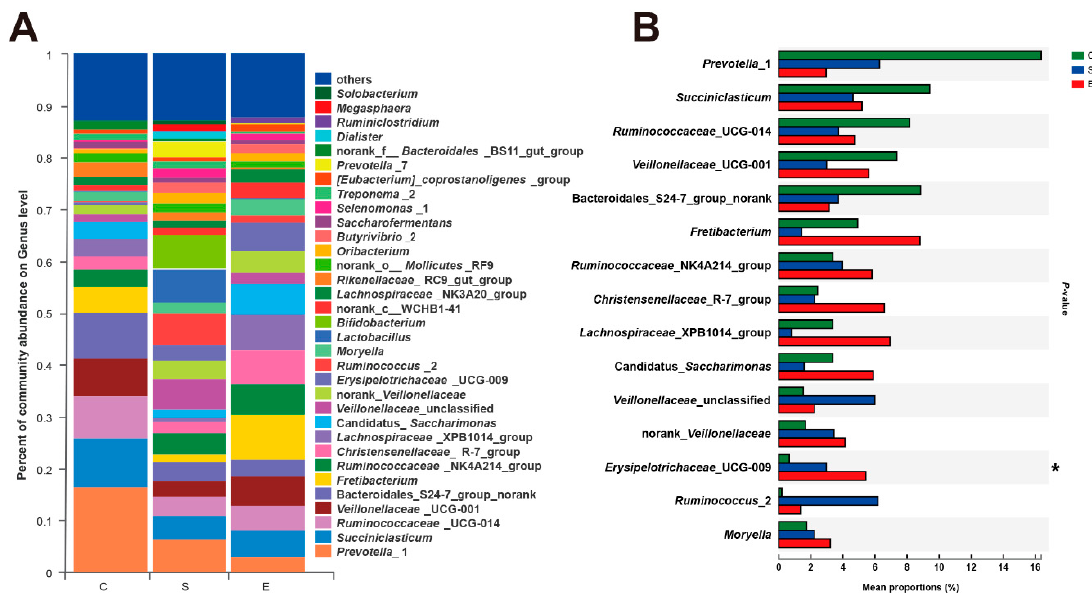
Figure 4. Distribution of genera in different groups. ( A )The color ‐ coded bar plot represents the average distributions of bacterial genera across the different feed types sampled. Only the dominant genera (those with a relative abundance ≥ 1%) among rumen bacteria are shown. ( B ) Extended error bar plots illustrate the mean proportions and differences in the bacterial genera in rumen samples. Corrected p < 0.05 was marked with *.